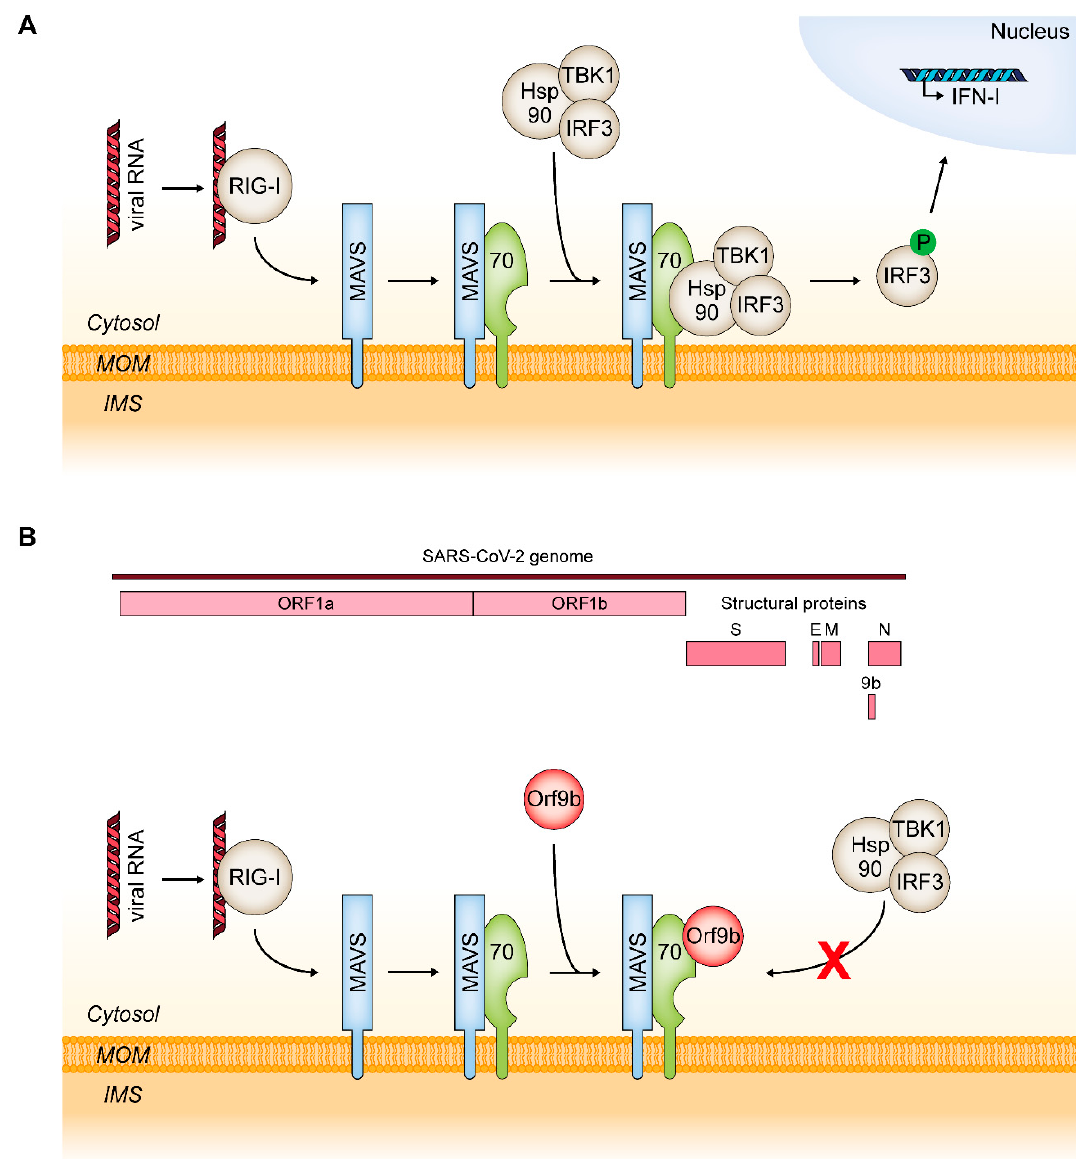
Figure 7. Function of TOM70 in antiviral signaling. ( A ): Upon RNA virus infection, helicase RIG-I binds to dsRNA which induces a conformational change that allows RIG-I to associate with mitochondria localized MAVS. This triggers MAVS to bind to TOM70 which subsequently leads to binding of the Hsp90 / TBK1 / IRF3 complex and formation of a MAVS / TOM70 / Hsp90 / TBK1 / IRF3 supercomplex. TBK1 phosphorylates IRF3 which subsequently dissociates from the supercomplex and translocates into the nucleus to promote transcription of genes encoding proteins such as type I interferons (IFN-I). ( B ): Orf9b is an alternative reading frame on the SARS-CoV-2 RNA genome encoding for an 11 kDa protein which binds to TOM70 and inhibits the antiviral IFN-I response. IFN-I, interferon type I; IRF3, interferon regulatory factor 3; MAVS, mitochondrial antiviral signaling protein; RIG-I, encoded by the retinoic acid-inducible gene 1; TBK1, TANK-binding kinase 1.